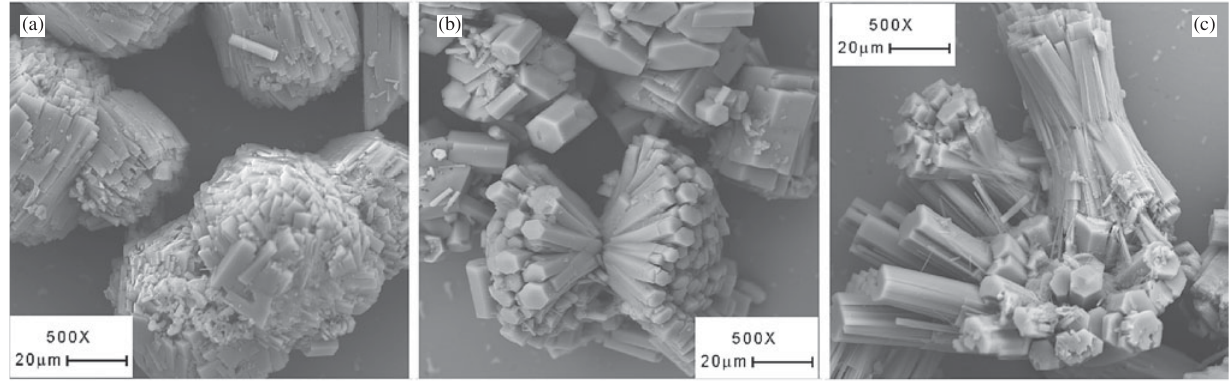
Figure 6. Micrographs of TAPO-5, with 46 h crystallization ( a ) Ti1, ( b ) Ti3 and ( c )Ti10.